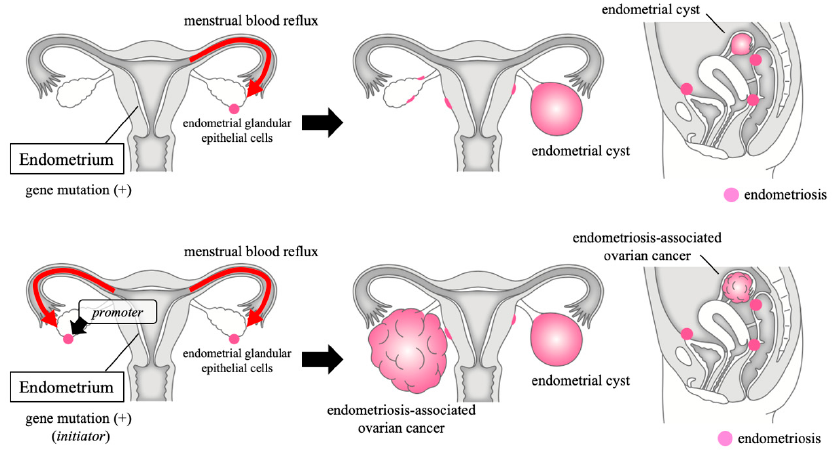
Figure 2. Mechanism of endometriosis-associated ovarian cancer carcinogenesis. Carcinogenesis requires an initiator and a promoter. Gene mutations occur frequently in endometrial glandular epithelial cells, but its mutations are often insu ffi cient as initiators. Nonetheless, endometrial glandular epithelial cells with su ffi cient gene mutations cause carcinogenesis through the e ff ect of the promoter. If they survive in the contralateral ovary or outside the ovary, they may not cause carcinogenesis, and such cells become endometriosis. This figure was made by modifying a figure from Clinical Gynecology and Obstetrics 2020